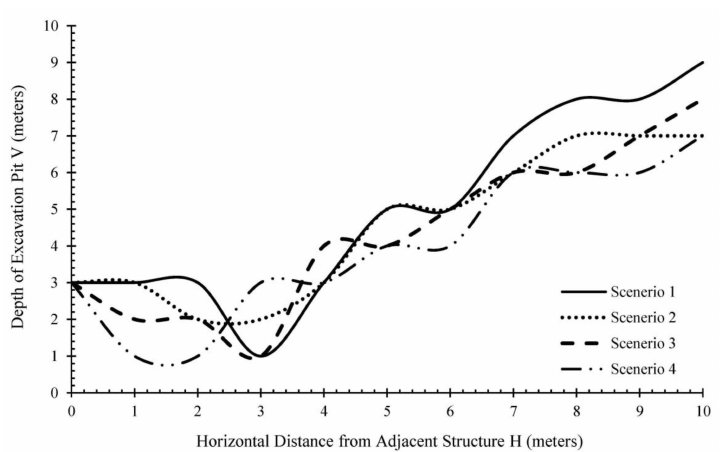
Fig. 10. Plot of all Scenarios for critical values of H and